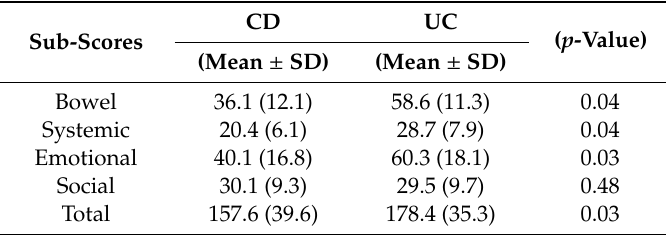
Table 3. Total and partial IBDQ32 scores for the control group.